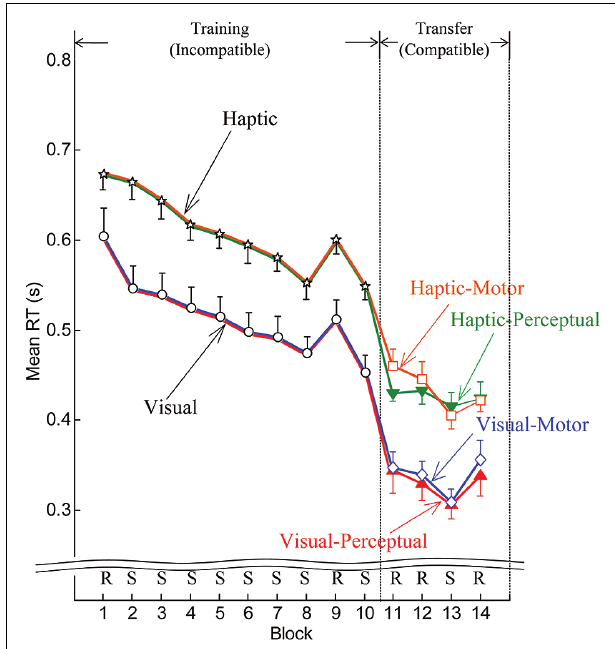
FIGURE 3 | Mean by group and subgroup of individual median RTs for the training phase (blocks 1–10) and transfer phase (blocks 11–14). Error bars are ± 1 standard error of the mean. R and S stand for pseudorandom and sequenced stimuli, respectively.